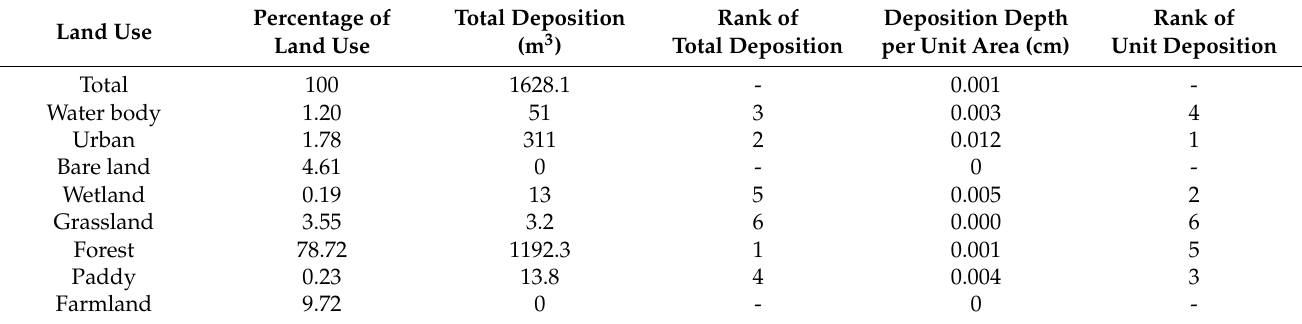
Table 6. Results of deposition for land use